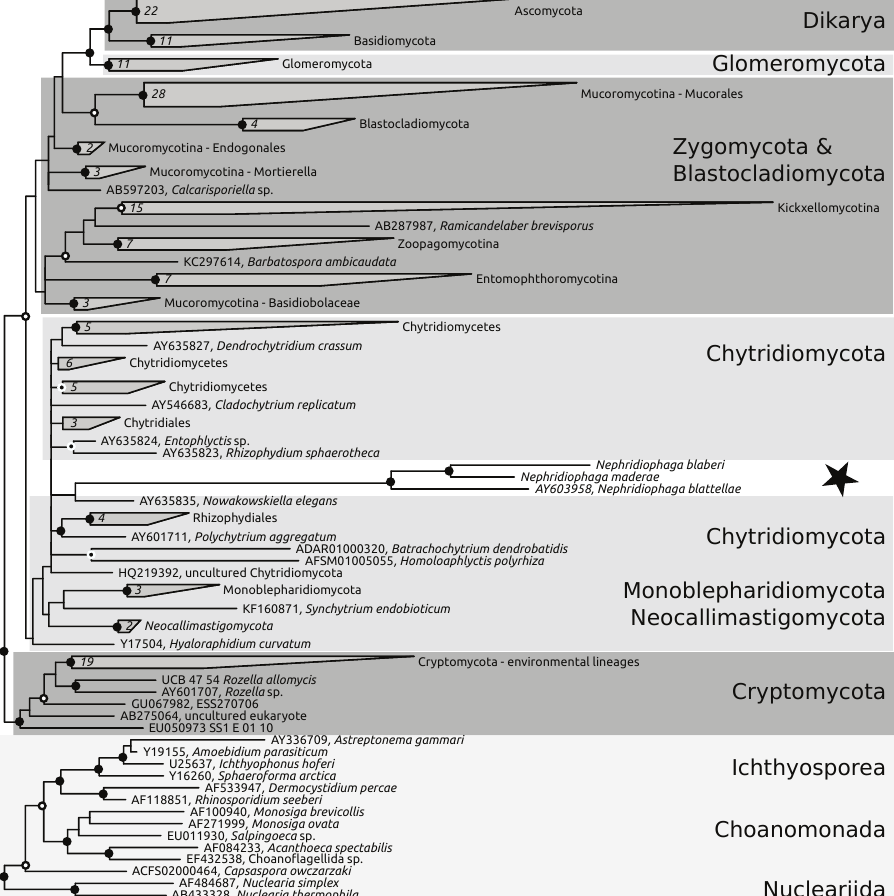
Figure 15. Bayesian phylogenetic tree including major lineages of the Holomycota (Liu et al. 2009; syn.: Nucletmycea , Brown et al. 2009), i.e. Fungi, Cryptomycota, and the basal Nucleariida, together with Holomycota sister clades Choanomonada, Ichthyosporea, and Filasterea (Holozoa; Lang et al. 2002). Nephridiophaga species (star) form a clade together with the flagellate fungi, here indicated as Chytridio- mycota s.l. The scale indicates expected changes per site. Branch support is given as Bayesian posterior probabilities above 0.95 (black circles) and maximum likelihood resampling values above 90% (white circles). Filled black circles mark support from both